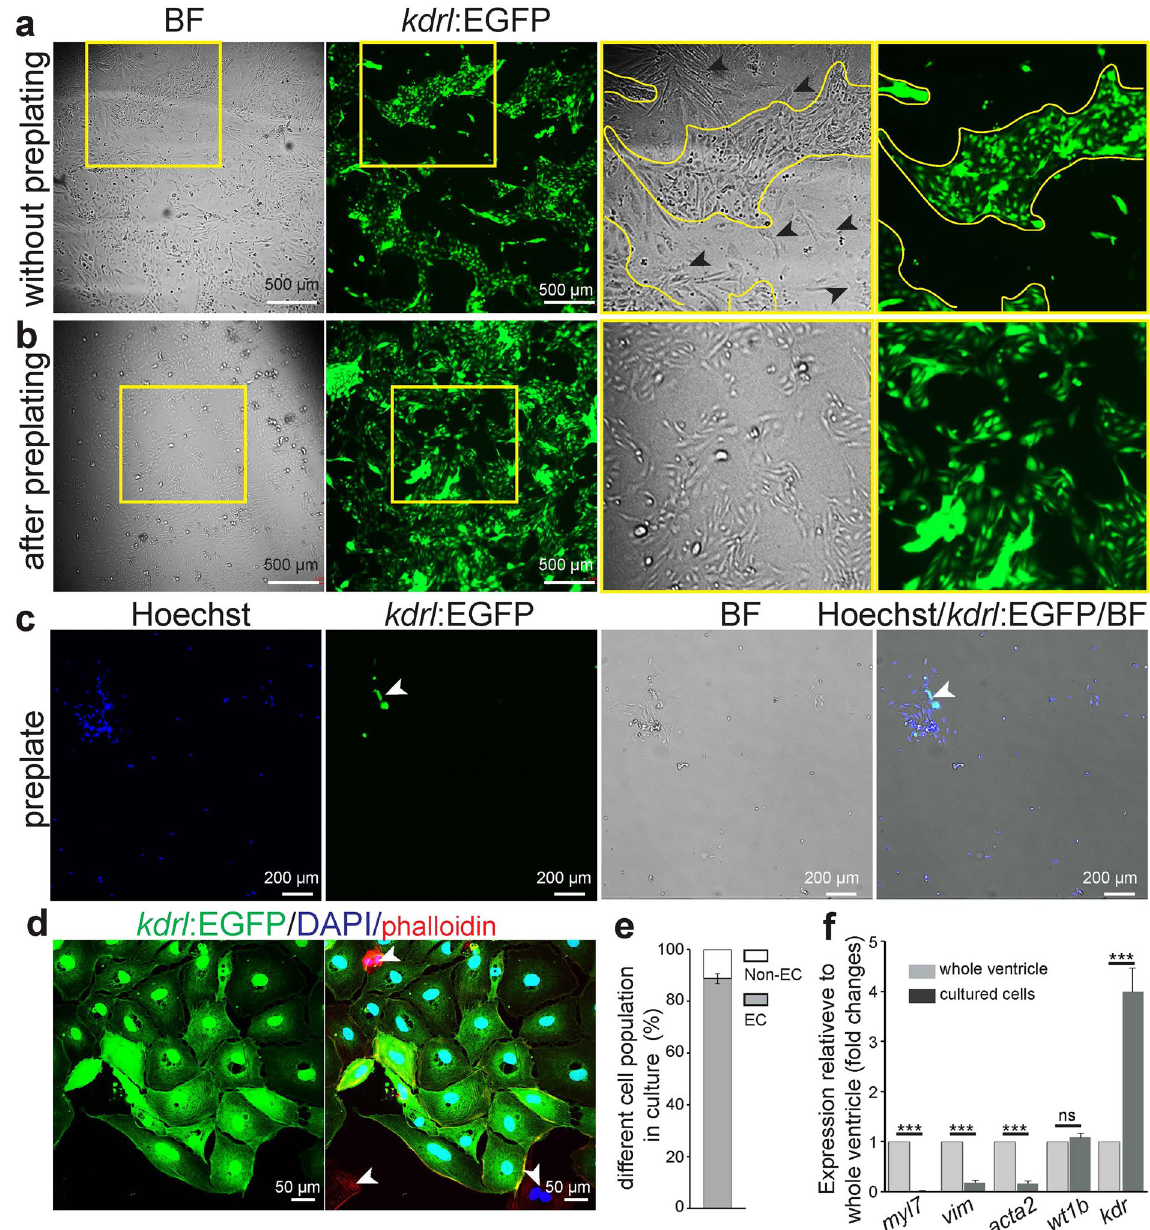
Figure 4. Culture of ventricular endothelial cells isolated from adult Tg(kdrl:EGFP) zebrafish. ( a–b ) Brightfield and fluorescence images of cultured cells (60 h after seeding) on a fibronectin coated culture dish without a preplating step ( a ) or after a 4 h preplating step ( b ). Black arrowheads, non-endothelial cells; BF- Brightfield. ( c ) Example of brightfield and fluorescence images (green for EGFP positive endothelial cells, and blue for nuclei (Hoechst 33342)) of isolated live ventricular cells on the preplate, after 4 h preplating. ( d ) Example of cultured cardiac endothelial cells after 1 st passage, stained for EGFP (green), rhodamine phalloidin (all cell types, red), and DAPI (nuclei, blue). ( e ) Quantification of endothelial cells to total cells after 1 st passage, showing high purity of the cultures. (n = 3, mean ± SEM). ( f ) RT-qPCR analysis using cardiomyocyte ( myl7 ), fibroblast ( vim ), smooth muscle cell ( acta2 ), epicardial ( wt1b ), and endothelial ( kdr ) markers (n = 3, mean ± SEM). Marker gene mRNA expression levels relative to α -tubulin were calculated using the Δ Ct method (ct values are indicated in the Supplemental Table 2). Expression is relative to the individual marker’s expression in whole cardiac ventricles. All non-endothelial markers, besides wt1b , are depleted in the isolated cell population. Concomitantly, the isolated cells show enrichment for the endothelial marker kdr . One way ANOVA followed by Bonferroni’s post-hoc test (GraphPad Prism) was performed to evaluate statistical significance of differences. P < 0.05 was considered statistically significant. *** corresponds to P <